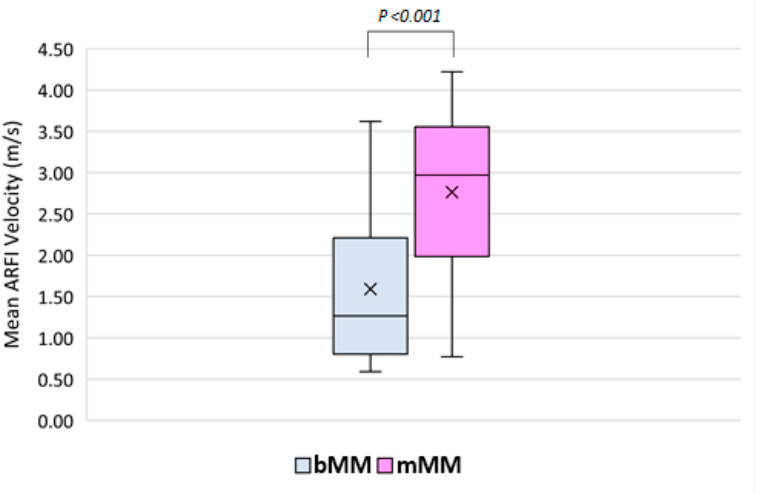
Figure 4. Differences in mean acoustic radiation force impulse (ARFI) velocities between benign and malignant mesenteric masses in the study. The mean ARFI velocity (MAV) in m/s is represented with an “X” in each box, and the median ARFI velocity in subgroups is shown as a horizontal line within each box. bMM: benign mesenteric mass (MAV = 1.59 ± 0.90 m/s), mMM: malignant mesenteric mass (MAV = 2.76 ± 1.01 m/s) ( p <